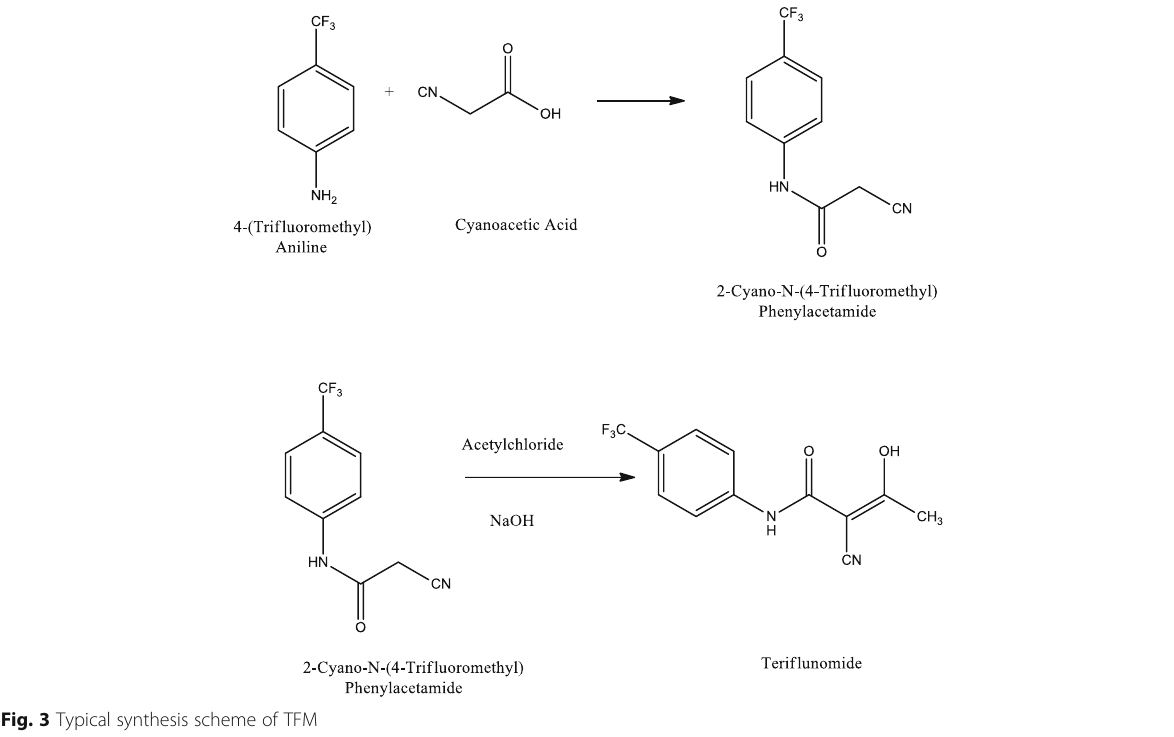
substance, based on the solubility study water, is se- lected as diluent. Preliminary tryouts were carried out based on the retention of CAA and peak shape with different columns using like Metrosep Super-Sep, Metrosep A Supp 3, Metrosep Anion Dual 2, and Metrosep A Supp 5 column, and different mobile phase combinations were used to investigate the evaluation of the analyte with sodium carbonate, so- dium bicarbonate, formic acid, potassium phthalate, and octane-1-sulfonic acid sodium salt. A better chro- matographic separation occurred at 504 mg of sodium bicarbonate and 53 mg of sodium carbonate in 1000 ml of water buffer, at a flow rate of 0.6 mL min − 1 with Metrosep A Supp 5, 6.1006.530, (250 mm × 4.0 mm) 5 μ m at 40 °C temperature.